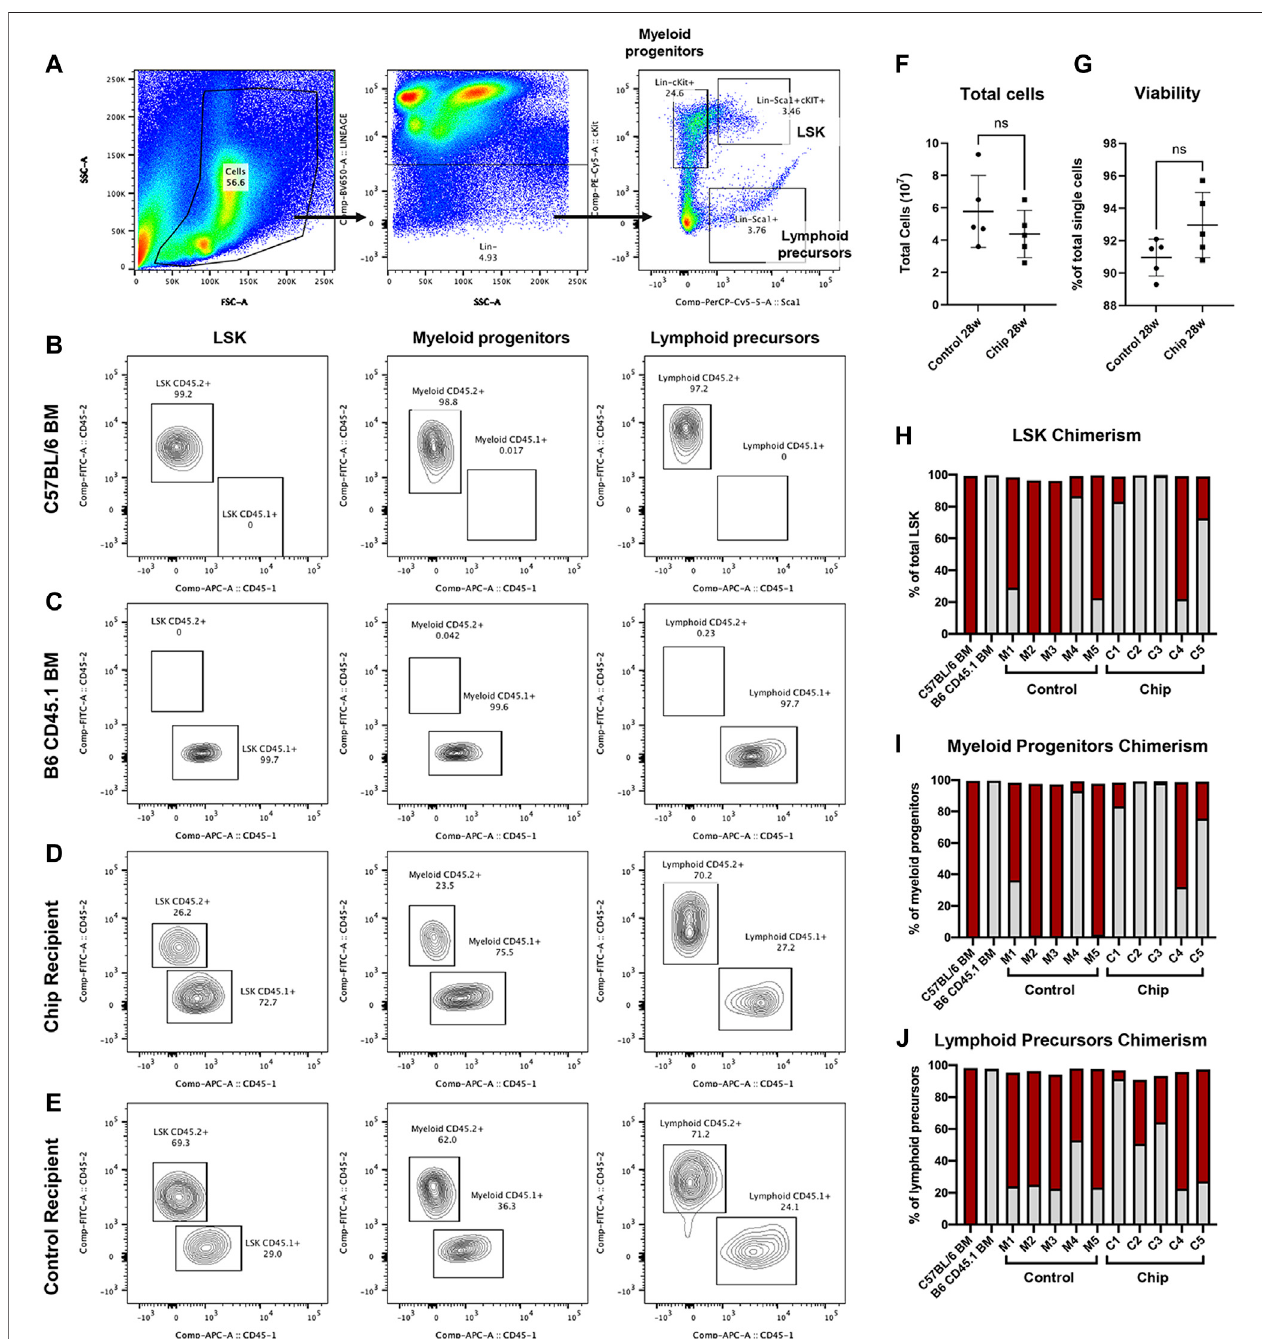
FIGURE6| EngraftmentandrepopulationofHSPC, myeloidprogenitor,and lymphoidprecursorpopulationsinbonemarrowbyBMME-on-chip grown LSKcells. (A) Bone marrow of recipient mice was isolated and analyzed using fl ow cytometry for lineage markers, stem cell markers Sca1+ and cKit+. (B – E) Representative contour plots of CD45.1+ and CD45.2+ in LSK (Lin-cKit + Sca1+), myeloid (lin-cKit+), and lymphoid (lin-Sca1+) cells in bone marrow of (B) CD45.2+ C5BL/6J, (C) B6 CD45.1+, (D) chip transplant recipient, and (E) mouse marrow control recipient. (F) Quanti fi cation of total bone marrow cells after isolation. (G) Viability isolated bone marrow cellsusing fl owcytometry (negativeDAPIstaining). StatisticalanalysisforFandGwasperformedusinganunpaired t -test.ns=nosigni fi cance, errorbar= SD. (H – J) Chimerism ofLSK (H) ,myeloid (I) ,and lymphoid (J) cellsindicating repopulation ofCD45.2+donorcellsandcompetitorCD45.1+cellsinrecipientmice.Data show the percent of total cells analyzed using fl ow cytometry of bone marrow from each recipient mouse. In particular, control recipients M1, M4, and M5, and chip recipients C1, C4, and C5 show chimerism in LSK populations.